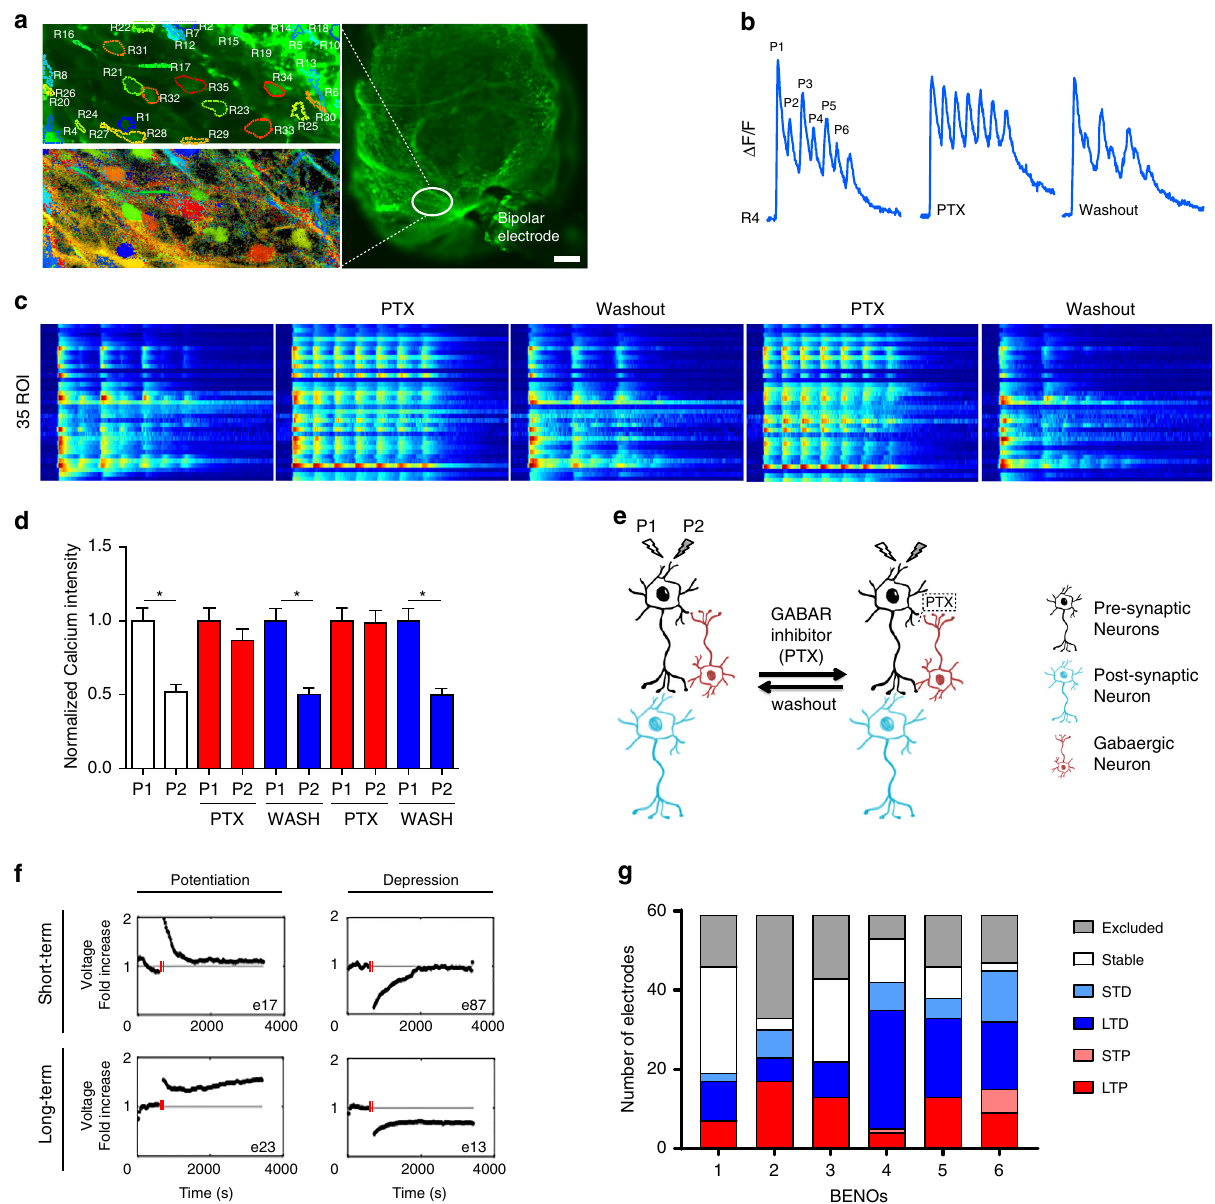
Fig. 6 Long-term and short-term neuronal plasticity in BENOs. a Right, overview image of a BENO d45 stimulated by a bipolar electrode. Scale bar: 200 µ m. Left, close-up view depicting 35 ROIs and the respective active correlation map (same color indicates synchronized activity in network of excitable neurons). Repetition of this experiment on another BENO on d49 is presented in Supplementary Fig. 9b. b representative trace showing paired-pulse depression (PPD) between 2 consecutive pulses (P1-P2, P3-P4, P5-P6). PPD was alleviated by PTX and restored upon washout. c Heat map of 35 ROIs recorded from a representative BENO showing PPD. d Statistical analysis of PPD - calcium activity of ROIs under normal conditions and repetitive treatments with PTX; n = 35 ROIs; in all comparisons * p <0.0001; unpaired two-tailed Student ’ s t test. e Schematic illustrating a simpli fi ed neuronal network with the mechanism underlying PPD. P1 activates the presynaptic neuron, which in turn activates a postsynaptic neuron and a GABAergic inhibitory neuron. As a result, the GABAergic neuron releases GABA, which binds to GABA A receptors in the presynaptic neurons resulting in inhibition and consequently decrease in calcium in fl ux. Blockade of GABA receptors by PTX uncouples the network and alleviates the PPD effect. f Examples for recordings of short- and long-term potentiation and depression from individual MEA electrodes ( e refer to activity heat map in Supplementary Fig. 9c, BENO 6), indicated by transient or sustained voltage alterations. HFS is indicated by three red lines. g Summary of LTP, LTD, STP, and STD recordings after HFS from six BENO slices (obtained from 6 individual BENOs labeled as 1 – 6 from 3 independent experiments). Note that each MEA enabled recordings from 59 electrodes; one electrode served as reference. Stable indicates neuronal signal recordings without depression or potentiation. Electrodes without signals are indicated in gray. Data are presented as mean these areas contained both glutamatergic and GABAergic neurons. These data are in agreement with our fi ndings and underline the formation. The expedited neuronal development in BENOs was